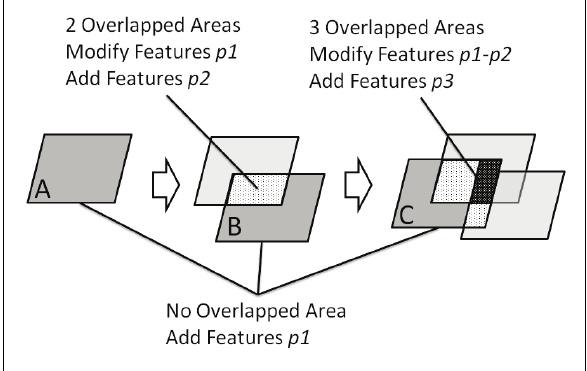
Figure 1: Simplified mapping process history and corresponding feature edition. Areas A, B and C represent three successive editing sessions (i.e., changesets). Feature types p1, p2 and p3 are higher to lower priority features